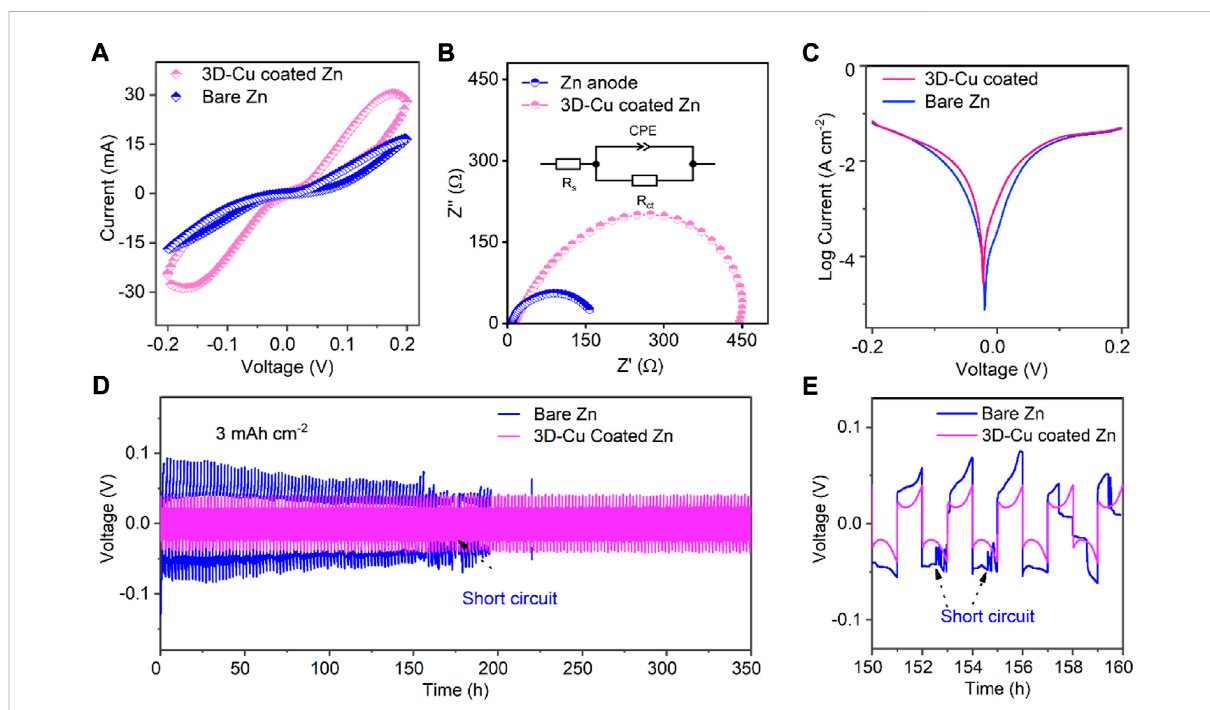
FIGURE 2 Electrochemical performance of 3D-Cu-coated electrodes and bare Zn in symmetric cells. (A) CV results at a scanning rate of 5 mV s − 1 . (B) EIS results of the symmetric cells at initial states and the inset is the equivalent circuit, where R s represents electric resistance, and R ct is the charge transfer resistance. (C) Tafel results of symmetric cells. (D) Plating/stripping results at 3 mA cm − 2 with a capacity of 3 mAh cm − 2 . (E) Selected voltage pro fi les to observe the short circuit of the cell based on bare